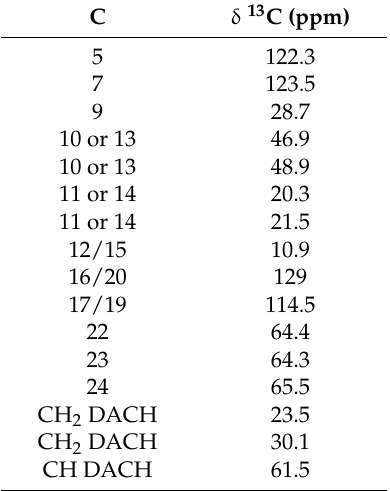
Table 1. Summary of 13 C chemical shifts of 3 in DMSO- d 6 .